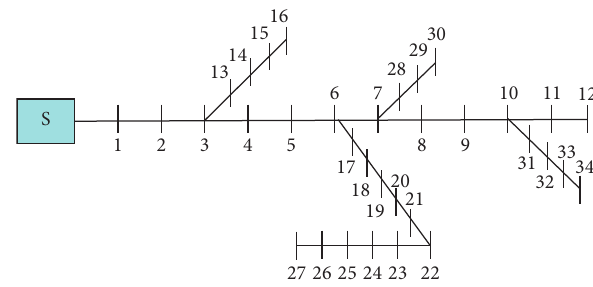
Figure 1: IEEE-34 bus radial distribution system [32].